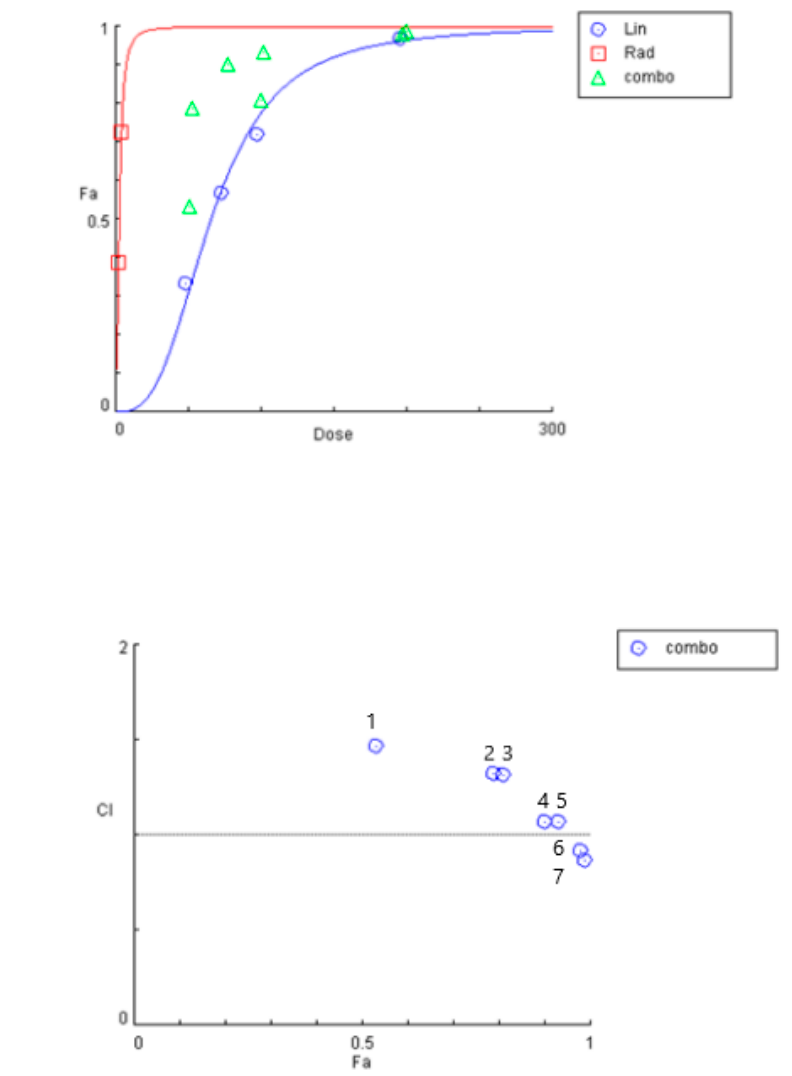
Figure 7. Compusyn analysis for the determination of possible synergistic effect of the treatment of linearol with radiation on U87 cells. ( a ) Dose–response curve of linearol and radiotherapy. Combo indicates the different combinations of linearol and radiation. ( b ) Combination index (CI) plot for all combinations. CI = 1 defines additive effect, CI < 1 defines synergism, whereas CI > 1 is antagonism. Numbers refer to different combinations used in the experiment. 1 = Lin 49 µ M + Rad 2 Gy, 2 = Lin 98 µ M + Rad 2 Gy, 3 = Lin 49 µ M + Rad 4 Gy, 4 = Lin 73.5 µ M + Rad 4 Gy, 5 = Lin 98 µ M + Rad 4